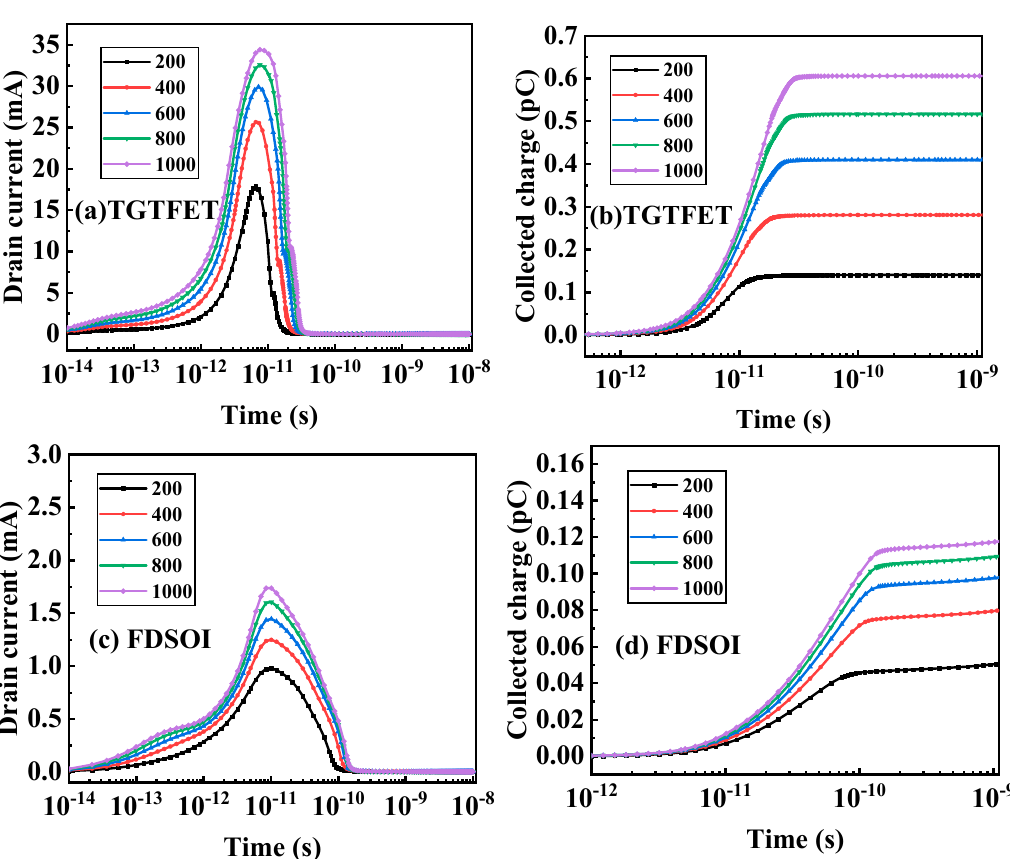
Figure 8. ( a ) Drain transient currents and ( b ) collected charges as a function of time after the ion strike with various LET in TGTFET. ( c ) Drain transient currents and ( d ) collected charges as a function of time after the ion strike with various LET in FDSOI. V d = 0.5 V. LET: MeV ∙ cm 2 /mg.